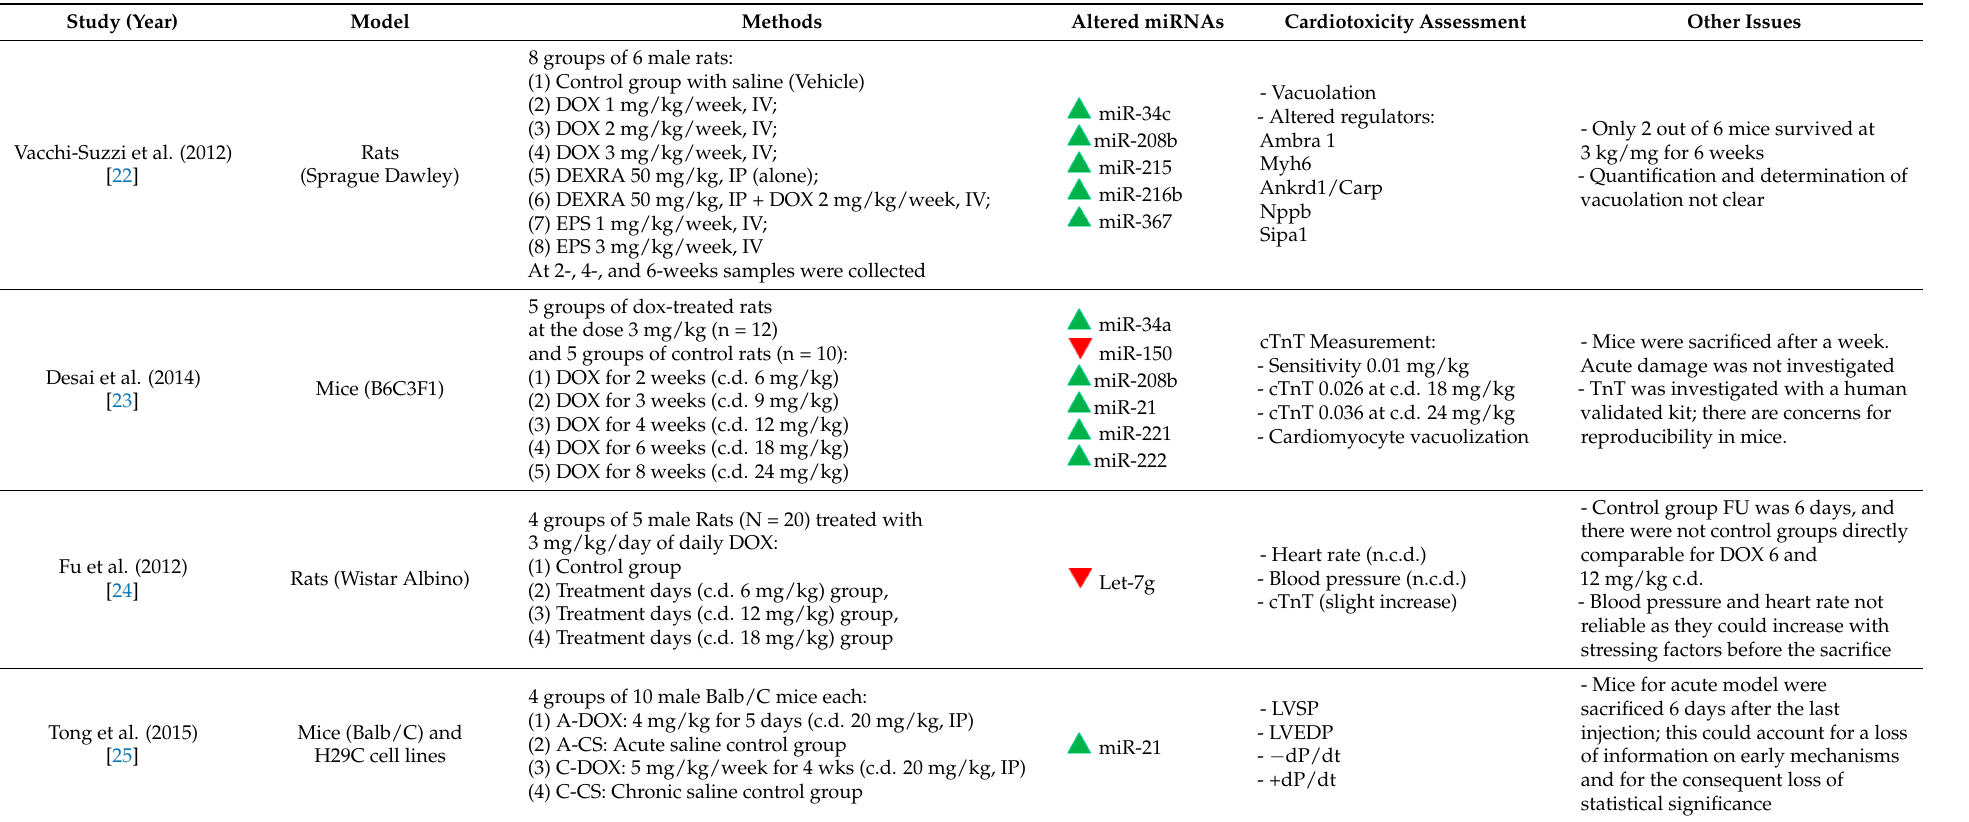
Table 1. Studies focused on experimental model heart tissues.